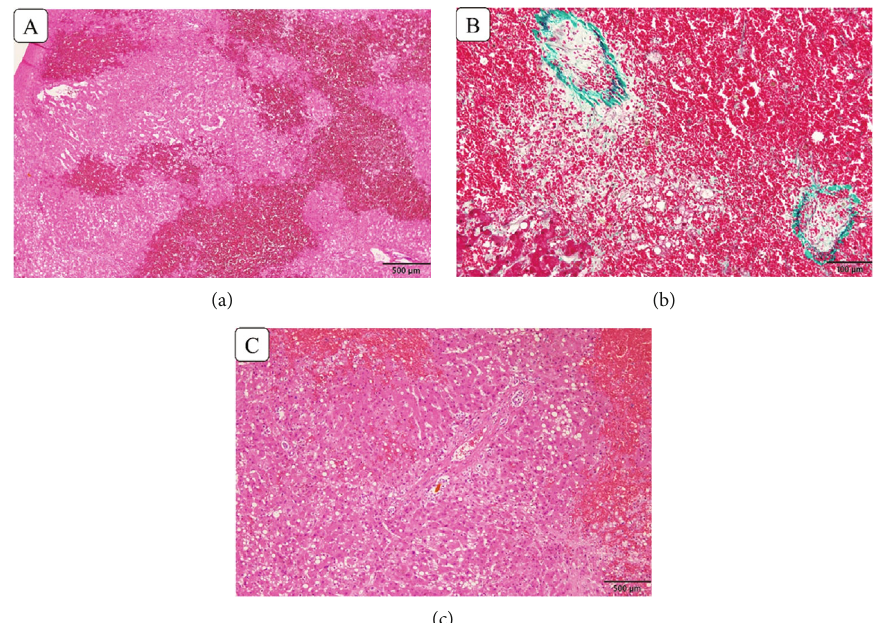
Figure 1: The histology of the explanted liver. (a) Hemorrhage and necrosis in the centrilobular lesion (zone 3). (b) Central vein obliteration. (c) Portal areas are relatively